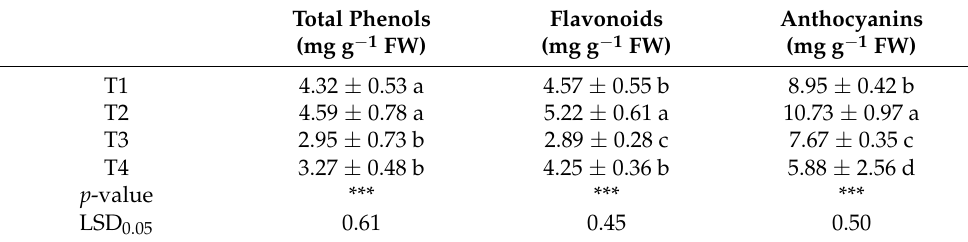
Table 3. Total phenol, flavonoid, and anthocyanin concentrations in spears from the four different plots: untreated control (T1), Brassica pellets (T2), chicken manure pellets (T3), and Dazomet